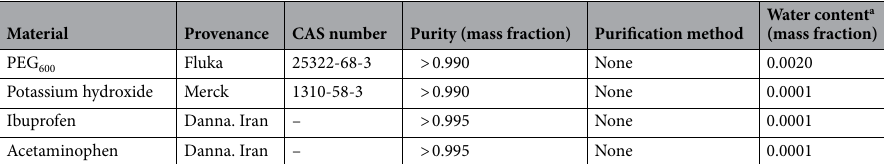
Experimental section